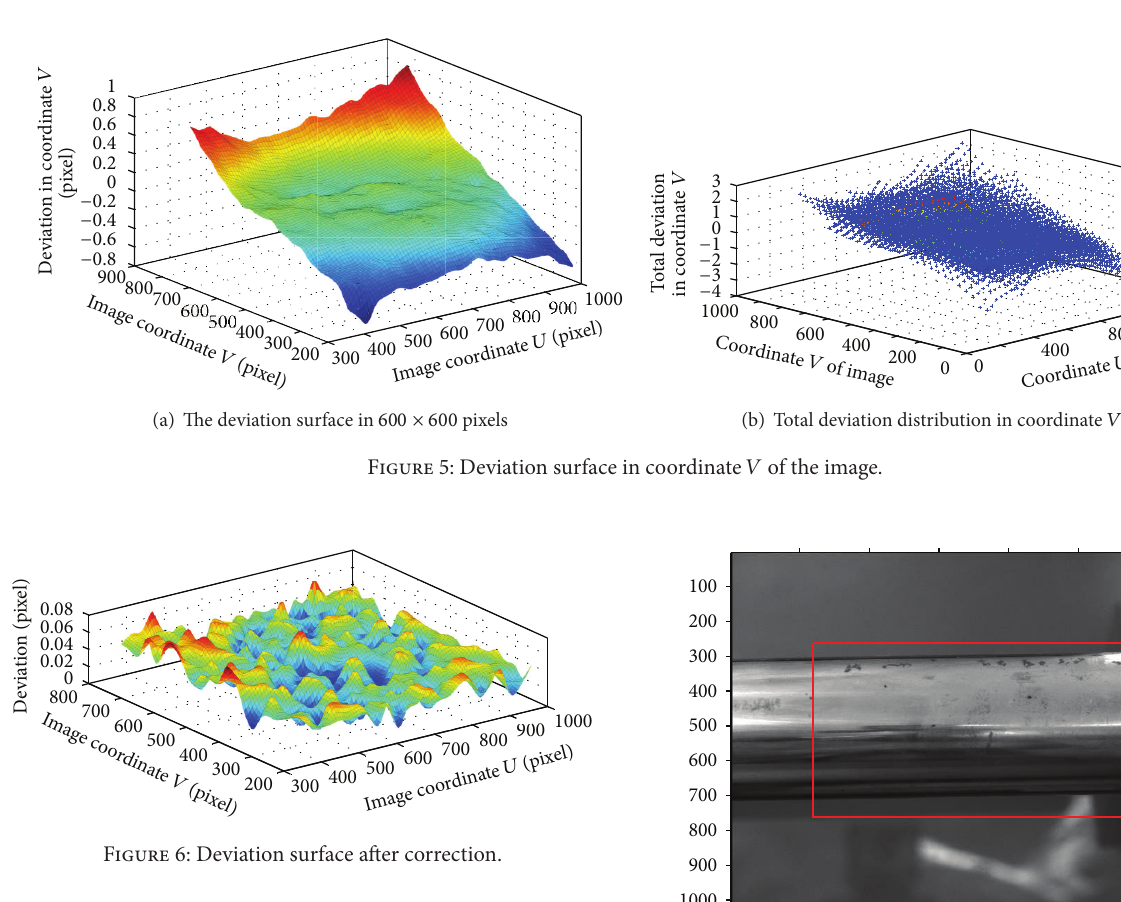
Figure 4: Deviation surface in coordinate 𝑈 of the image.